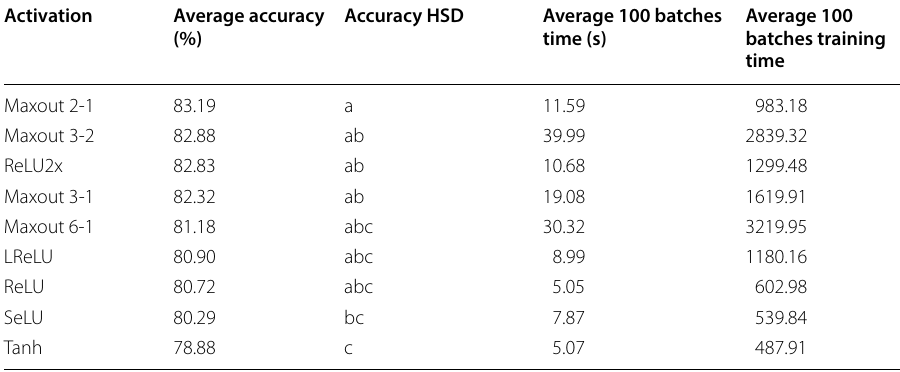
Table 13 Activation HSD test on sound